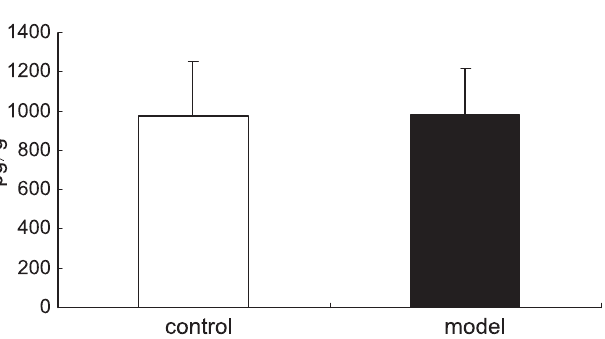
FIGURE 5 - Effects of hyperuricemia on IL-1β concentration in brain in 4 th week. Data are mean ±SD, n